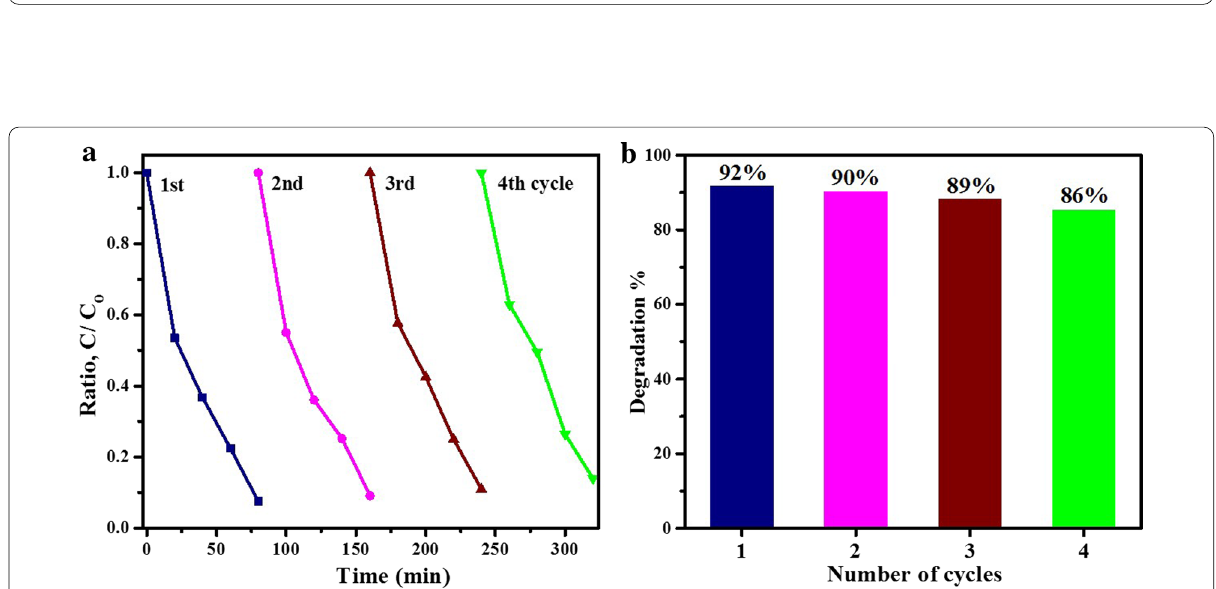
Fig. 9 a Results of MB degradation exhibited by fabricated photocatalysts b degradation % bar graph c ln (C o /C) vs. irradiation time plot and d calculated degradation rate constant graph